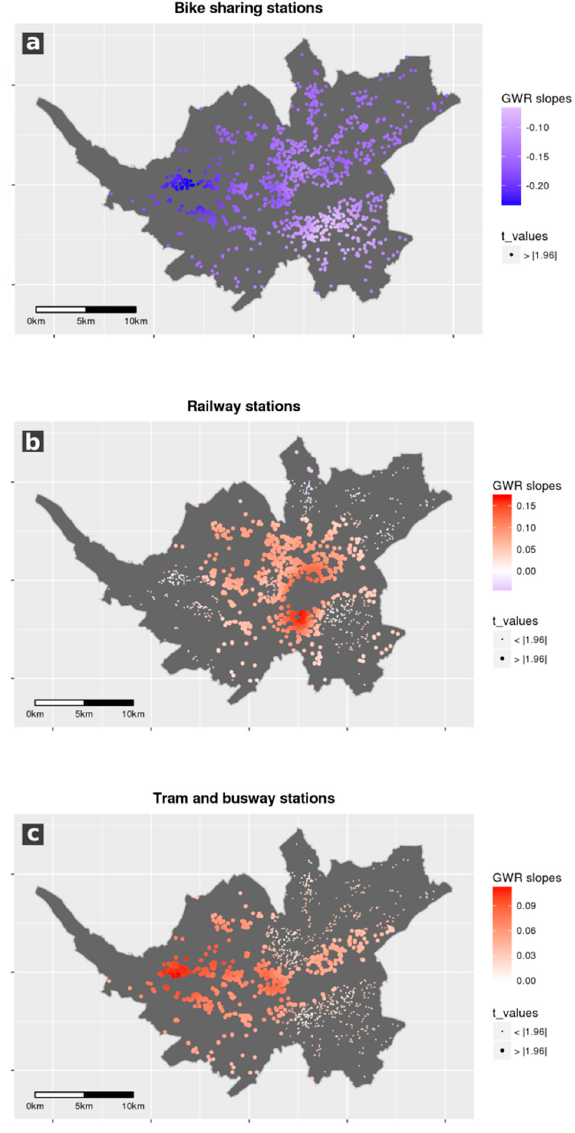
Figure 3. Map of GWR slopes in the Nantes Métropole area. ( a ) Bike-sharing stations; ( b ) Railway stations; ( c ) Tram and busway stations.